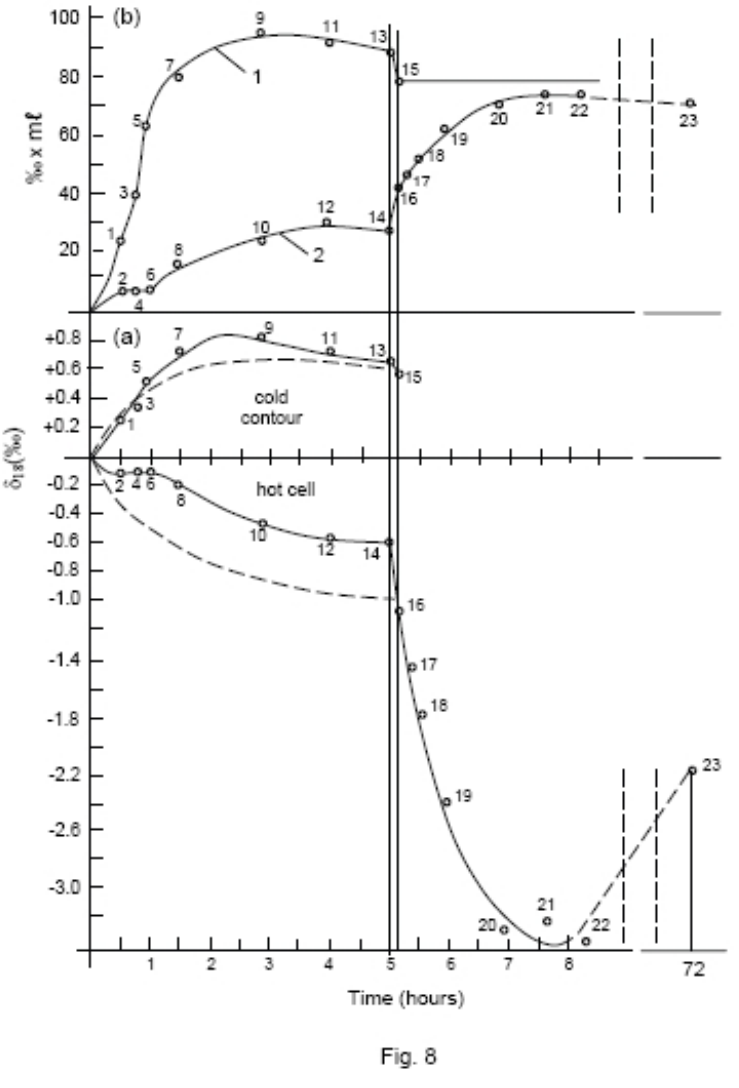
Fig. 8 Isotope separation of oxygen as a result of a temperature gradient across the membrane with simultaneous hydraulic flow through the membrane under pressure from the hot